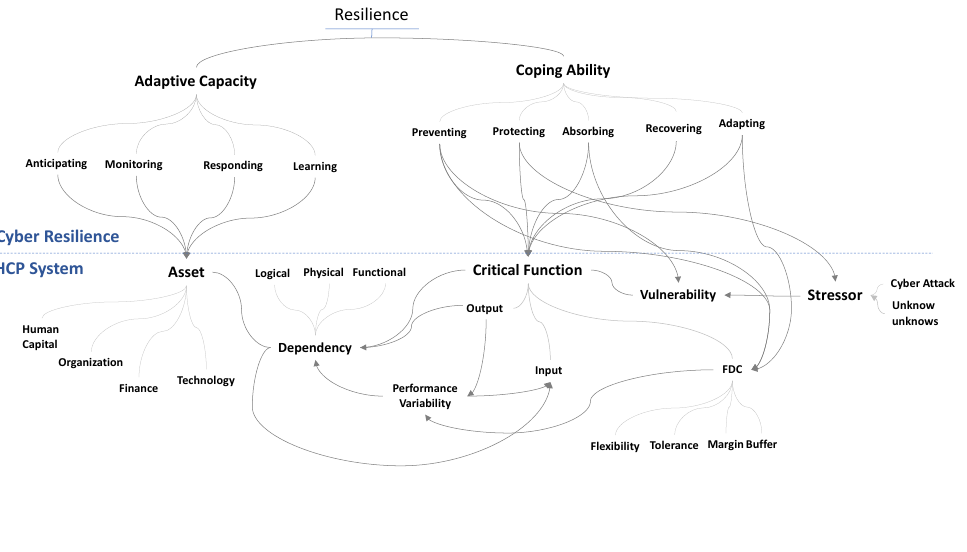
Figure 3. Resilience